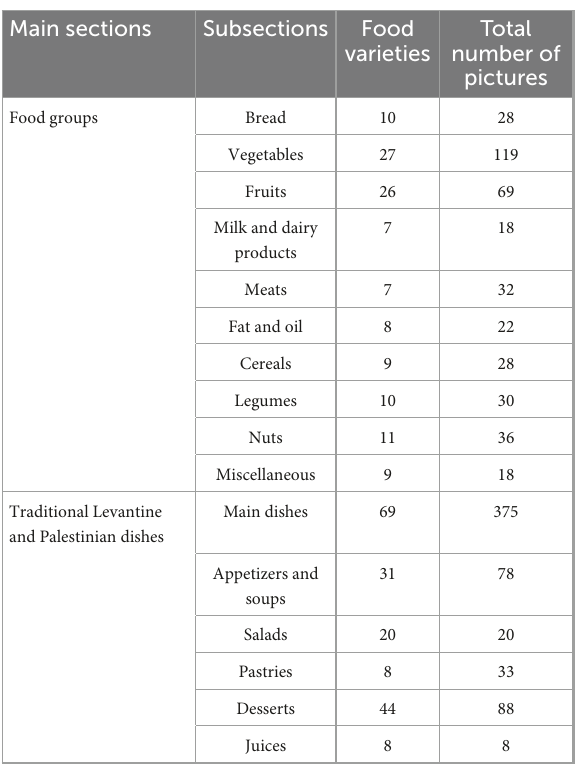
TABLE 1 Type and number of foods and traditional dishes included in photographic food atlas.